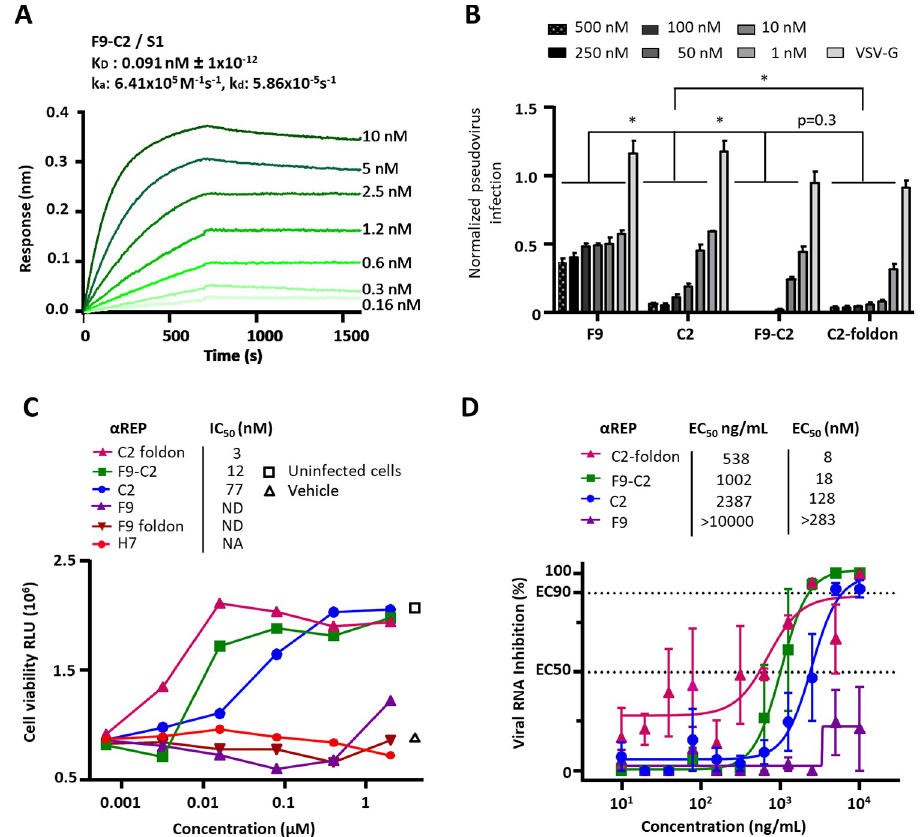
Fig 4. The F9-C2 and C2-foldon constructs properties. (A) BLI binding kinetics measurements for F9-C2 to the S1-immobilized biosensor. ( B) Pseudo-typed SARS-CoV-2 particles neutralization assay was performed with F9, C2, F9-C2 and C2-foldon constructs (n = 3, mean ± SEM, two-way ANOVA, � P < 0.0001). (C) Cell viability of SARS-CoV- 2-infected cells in presence of dilutions of F9-C2, C2-foldon, C2, F9 and H7 (an α Rep negative control) was monitored using the CellTiter-Glo Luminescent Assay Kit (Promega) (n = 2, mean is presented). Infected cells (triangle) and mock-infected cells (square) were included in the assay. Half maximal inhibitory concentration (IC 50 ) were